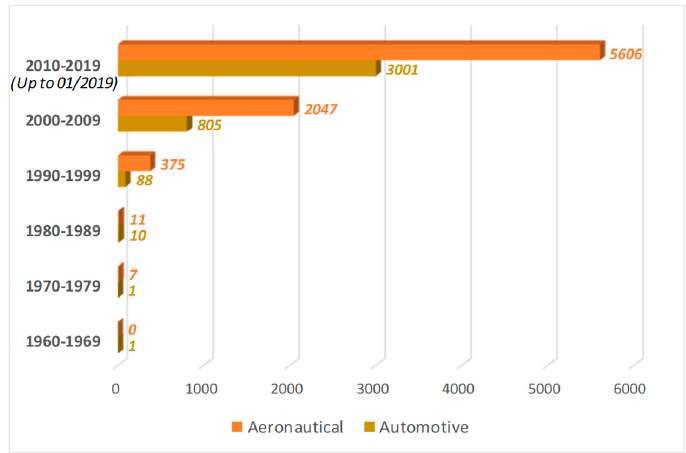
Figure 13. Articles published in the aeronautical and automotive fields. Sources: Scopus. Aeronautical keywords: (“Shape Memory Alloy” OR “Nitinol”) AND (“Aerospace” OR “Aeronautical” OR “Flight” OR “Aircraft”); Automotive keywords: (“Shape Memory Alloy” OR “Nitinol”) AND (“Automotive” OR “Car” OR “Vehicle”). Retrieved: 22/01/2019.